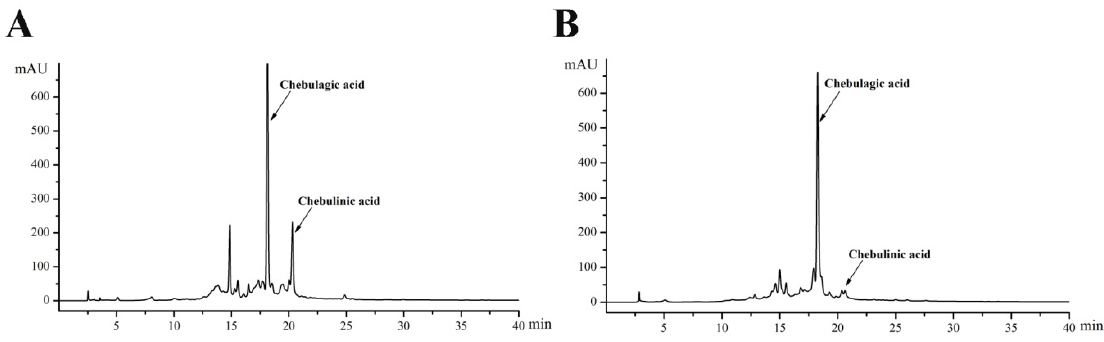
Figure 1. HPLC chromatograms of polyphenols from T. chebula extract, ( A ) ethyl acetate and ( B ) n-butanol fractions. Table 1. IC50 values of TPE and TPB in free radical scavenging